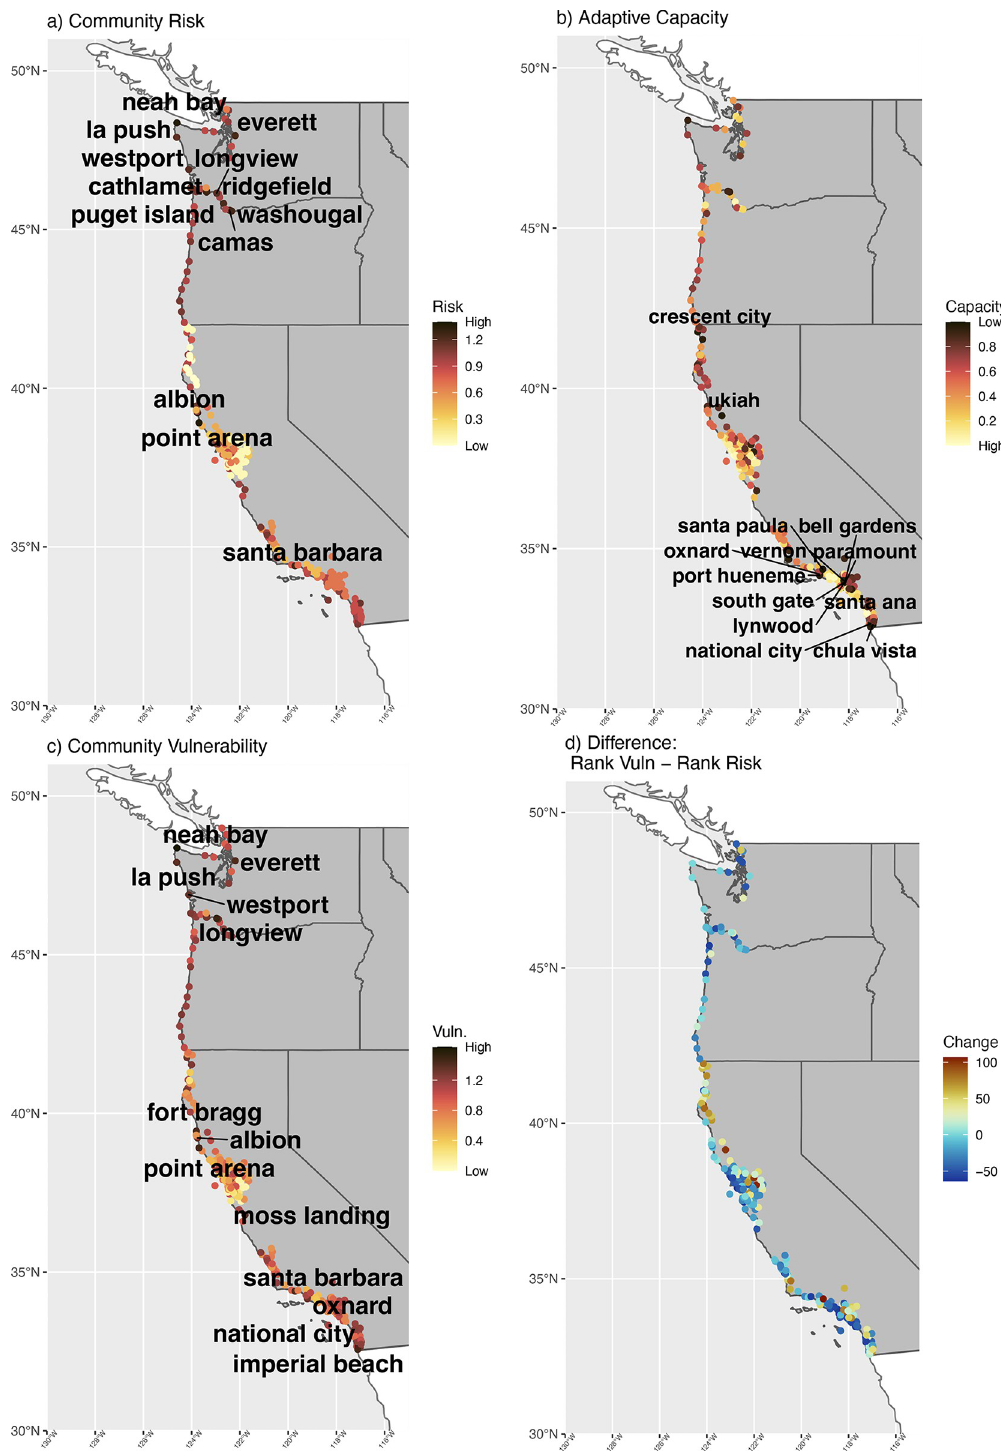
Fig 6. Top communities by risk, adaptive capacity, and vulnerability, as well as difference in rank scores between risk and vulnerability by community. Communities ranked by risk (top left) and adaptive capacity (top right), community vulnerability (bottom left) across the U.S. West Coast. Communities labeled are those in top 5 percentile of risk, adaptive capacity, or vulnerability. Considering social information (adaptive capacity) compared to solely ecological/economic data (risk) changes which communities are in the top for most imperiled, though others are ranked high across the board. Also, the